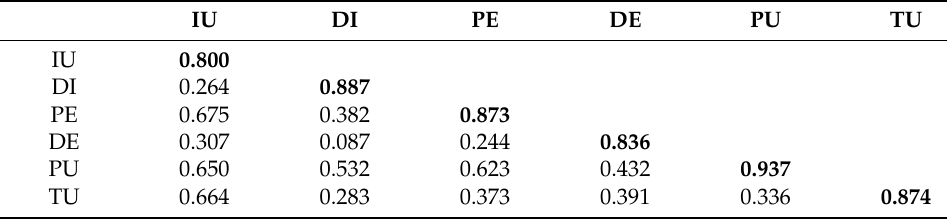
Table 5. Fornell–Larcker scale.